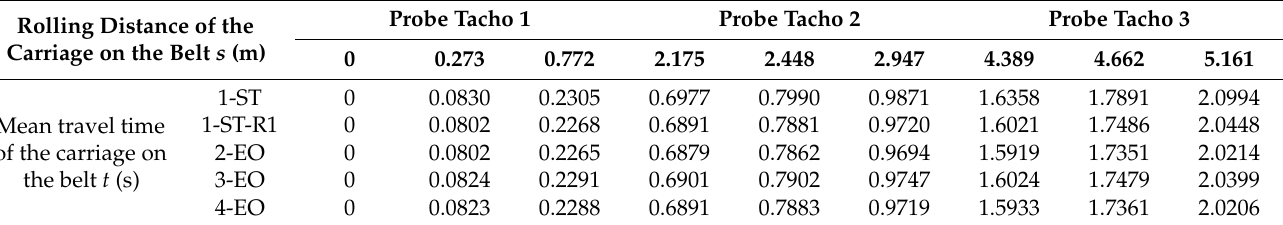
Table 4. Belt test results at a temperature of − 9.0 ± 2.0 ◦ C.